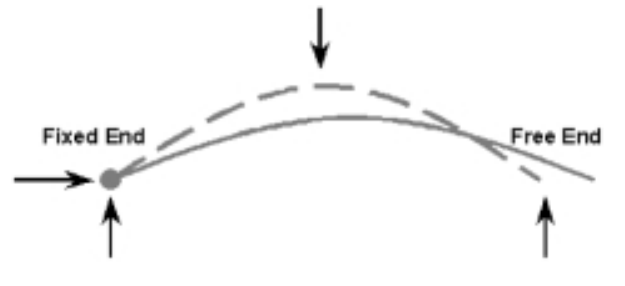
Fig. 7. Actuator endpoint movement under